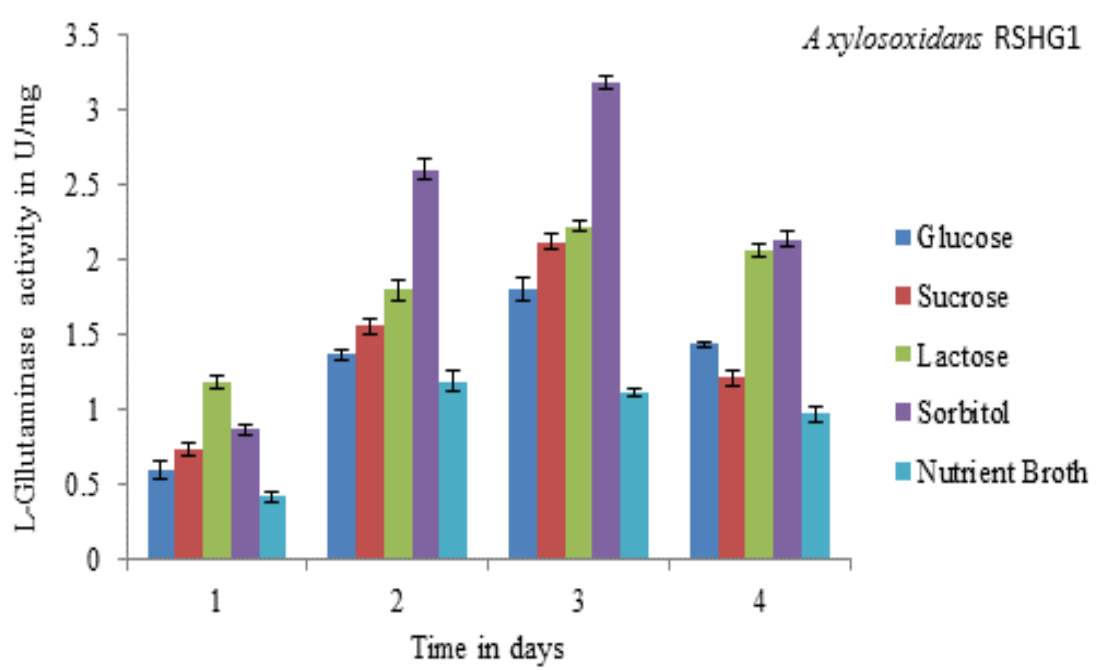
Figure 5. Effect of temperature on Glutaminase production by A. xylosoxidans RSHG1, pH 9.